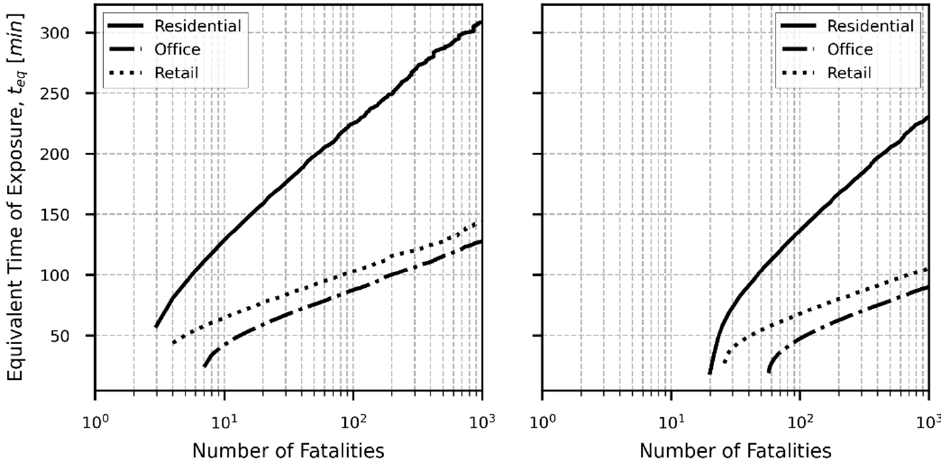
Figure 7. Minimum fire resistance in function of the number of fatalities based on the principle of relative (marginal) lifesaving costs ( left ) without sprinklers, ( right ) with sprinklers. Table 12 maps the fire resistance determined in function of the number of possible fatalities to the consequence classes in ISO 2394:2015, which have been partly adapted from EN 1991-1-7. Values are mapped to the highest number of possible fatalities in each consequence